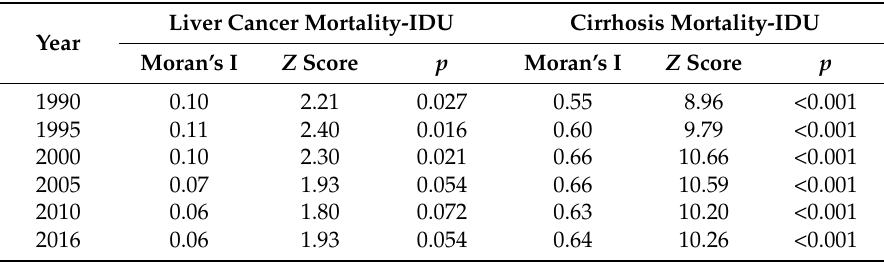
Table 1. Global spatial autocorrelation of IDU-attributable cirrhosis and IDU-attributable liver cancer mortality among 195 countries, 1990–2016. Liver Cancer Mortality-IDU Cirrhosis Year